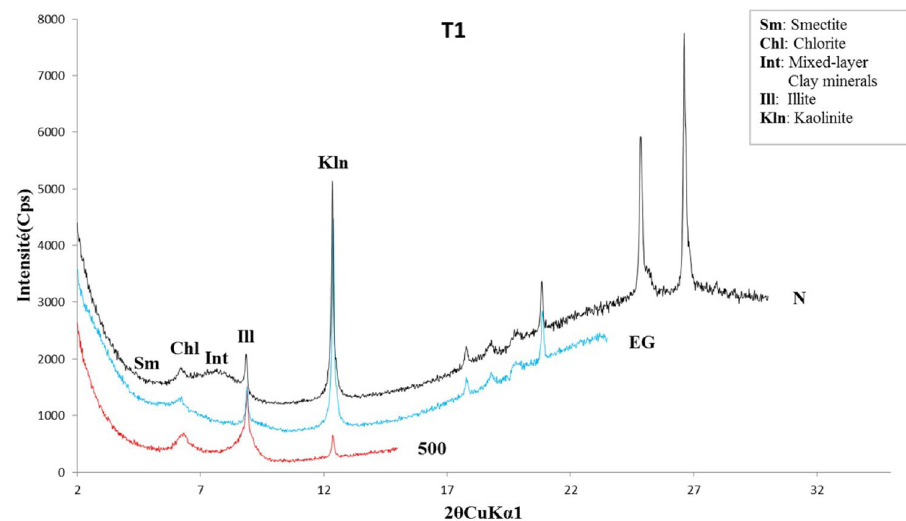
Fig. 4 X-ray diffraction pat- terns (N, EG, 500) for oriented preparations in < 2 µm clay fractions ( Sample: T1